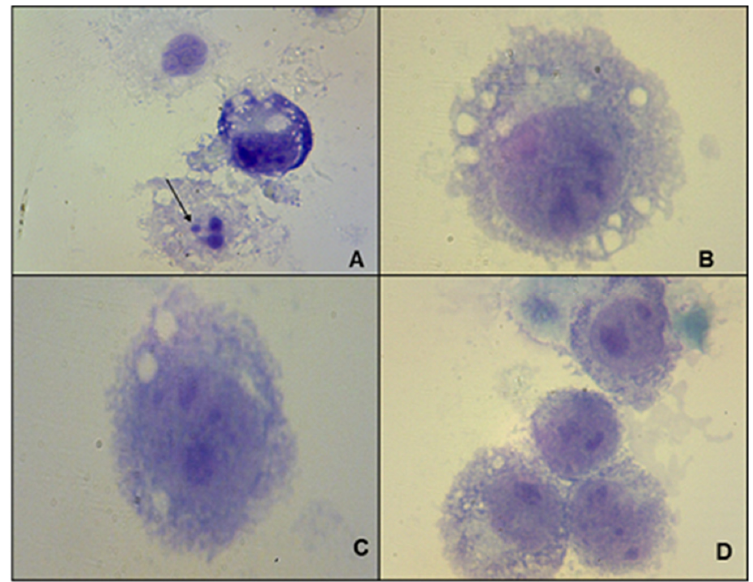
Figure 2. Macrophages J774 experimentally infected by Leishmania amazonensis. ( A ) negative control (0 µg mL − 1 ), ( B ) ACW-02 treated in concentration of 1 µg mL − 1 , ( C ) 16 µg mL − 1 and ( D ) 32 µg mL − 1 . The black arrow indicates the presence of the macrophage-internalized L. amazonensis amastigote. Stain: Giemsa 10%. Bars = 10 µm.